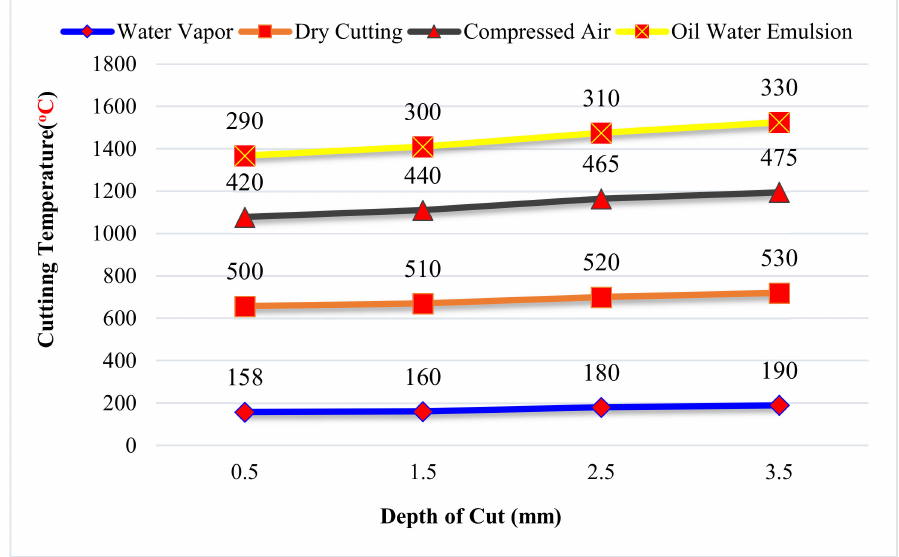
Figure 32. Cutting Temperature Variation on different Depth of cut, reprinted with permission from ref. [173]. Copyright 2004 Elsevier